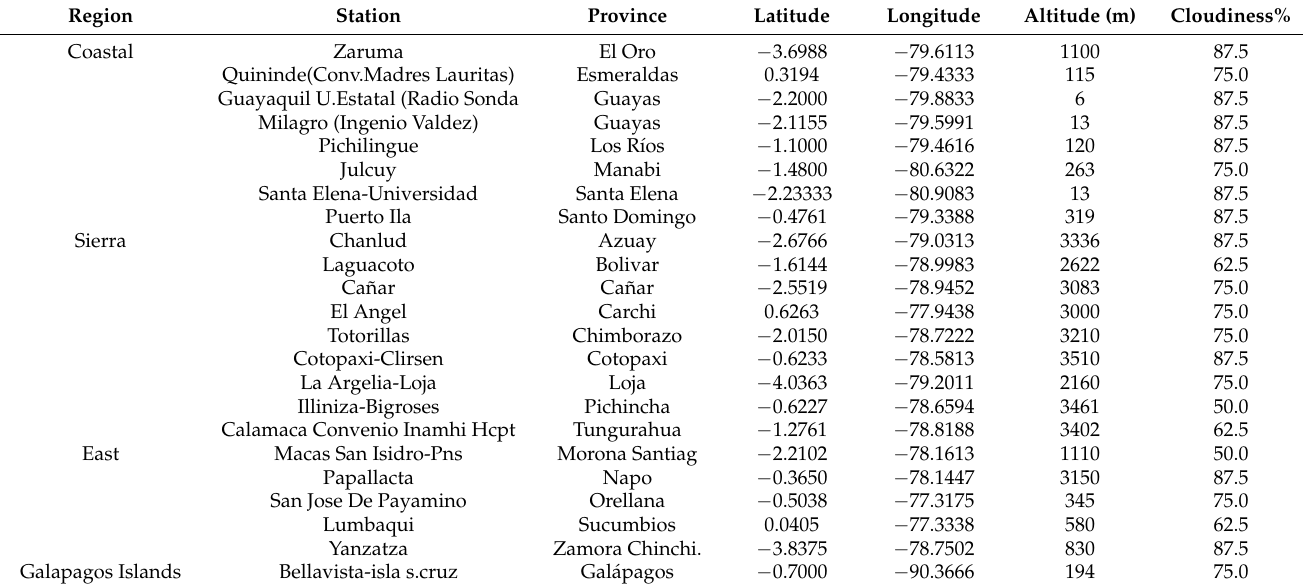
Table 1. Annual average of cloudiness index in various stations in